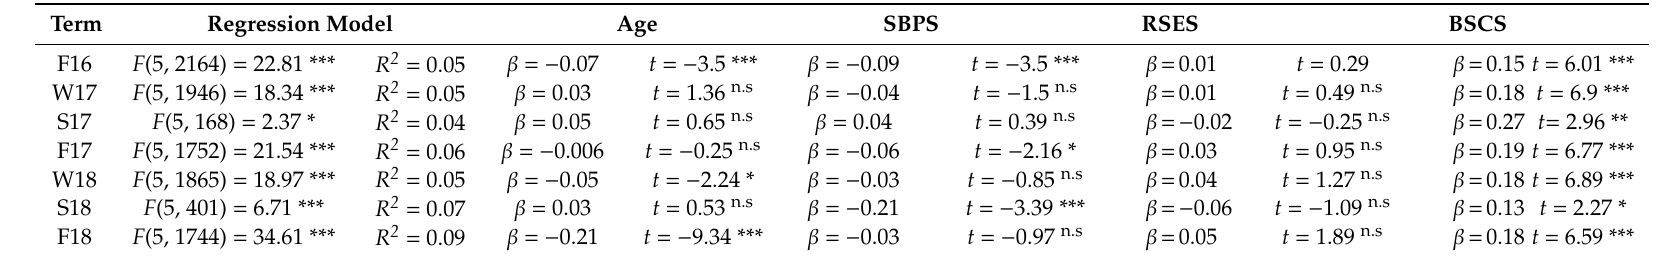
Table 5. Regression Models Looking at the Unique Contributions of Each Variable to grade point average